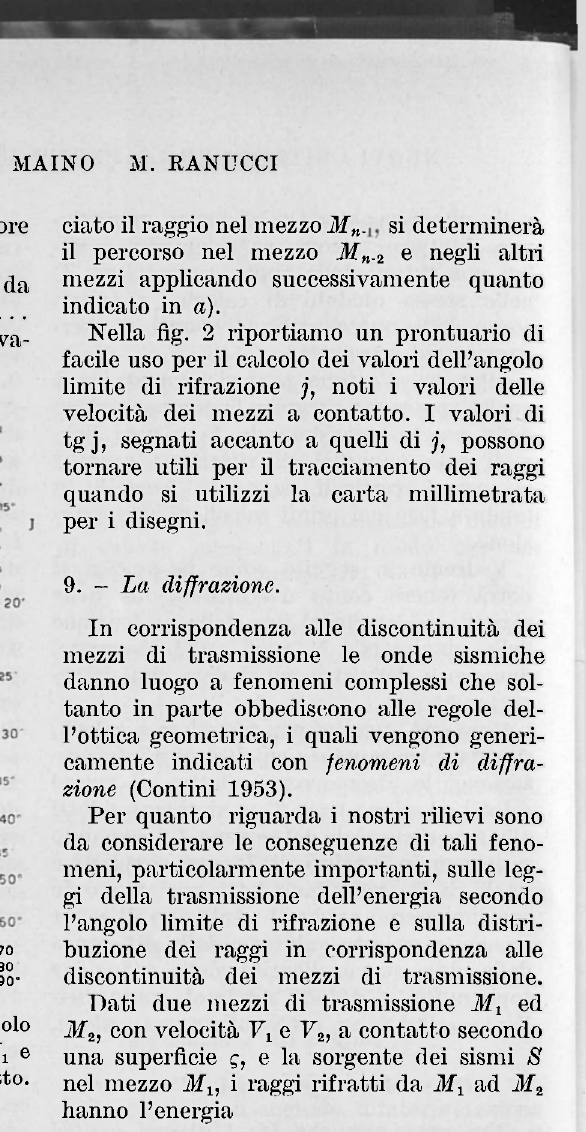
Fig. 2 - Prontuario di calcolo dell' angolo limite di rifrazione j note le velocità V 1 e V 2 dei mezzi di trasmissione a contatto.